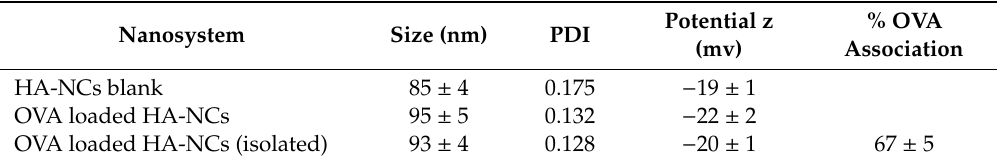
Table 1. Physicochemical characterization of hyaluronic acid nanocapsules (HA-NCs) loaded with ovalbumin (OVA) as model antigen. PDI: polydispersity